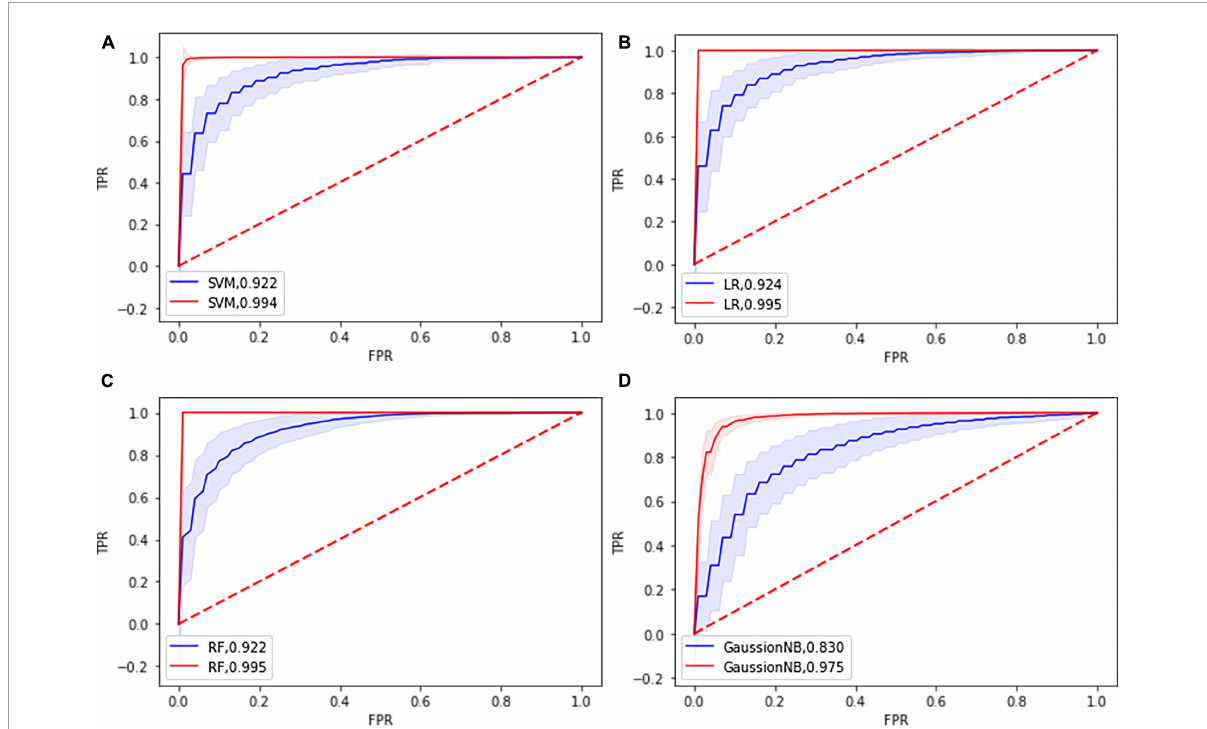
FIGURE3 Receiver operating characteristic curve (ROC) of the four classifier models based on the topological features in the training dataset (blue) and in the testing dataset (red). (A) SVM: support vector machine; (B) LR: Logistic Regression; (C) RF: Random Forest; (D) GuassionNB: gaussian naïve